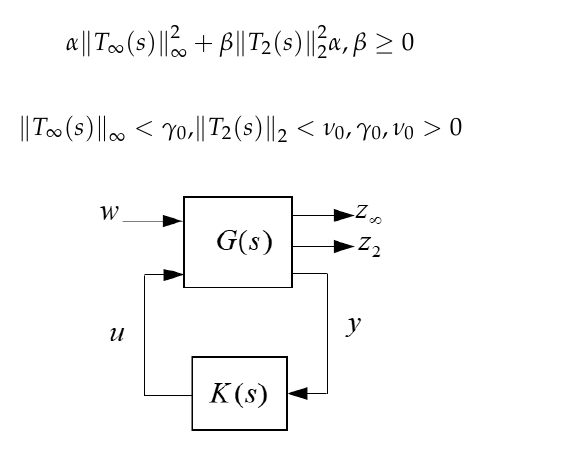
Figure 11. Multi-objective control structure.